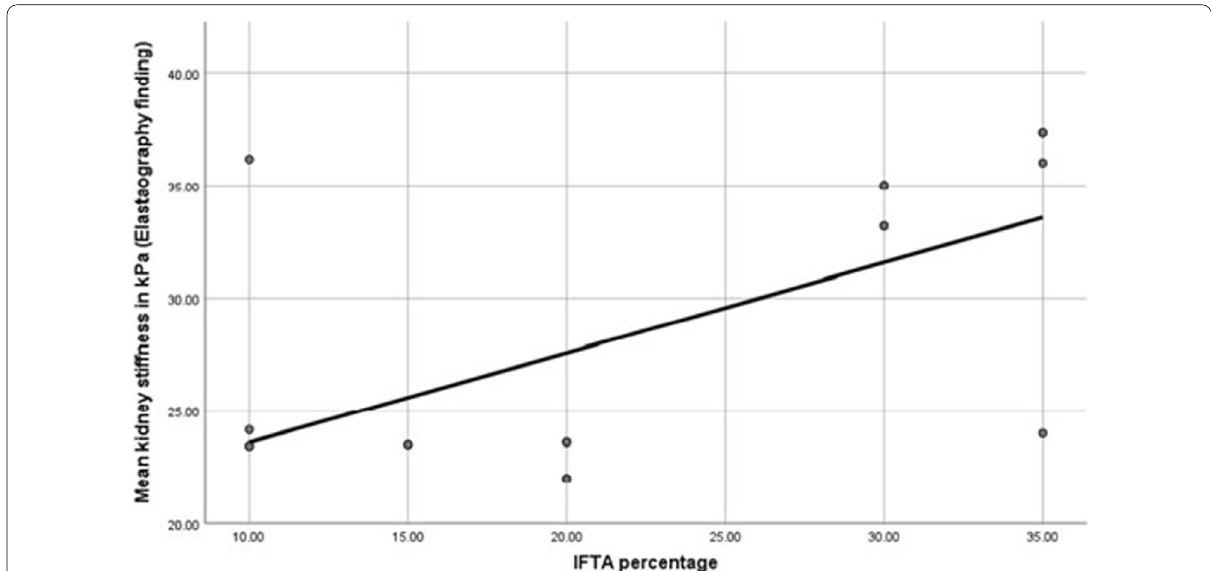
Fig. 3 Scatter plot showing the correlation between IF/TA percentage and mean renal stiffness in kPa